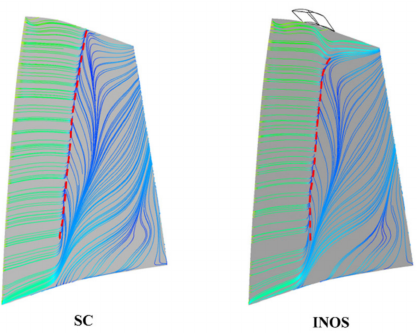
Figure 8. Streamlines on rotor’s suction surface at the near-stall condition (the left figure is reprinted from ref. [37]. Copyright 2021